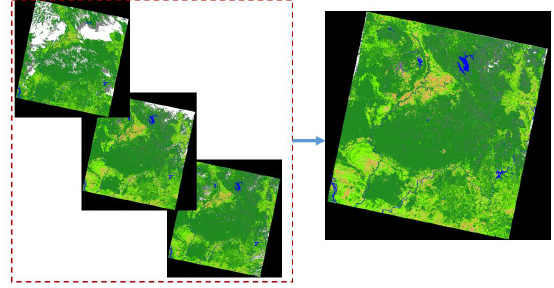
Figure 5. To demonstrate image stacking to create cloud free classified image. Single date classified images are in left side block. After stacking, cloud free image is created and shown in right side.